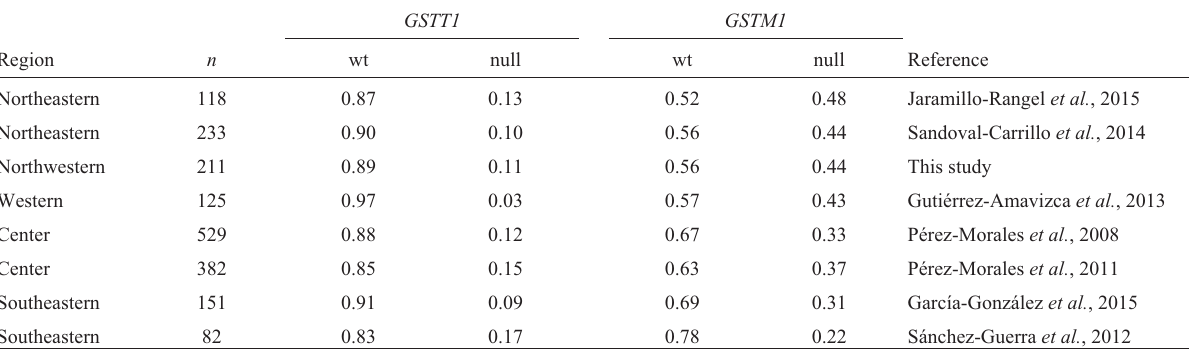
Table 1 - Frequencies of GSTT1 and GSTM1 null genotypes in different regions of